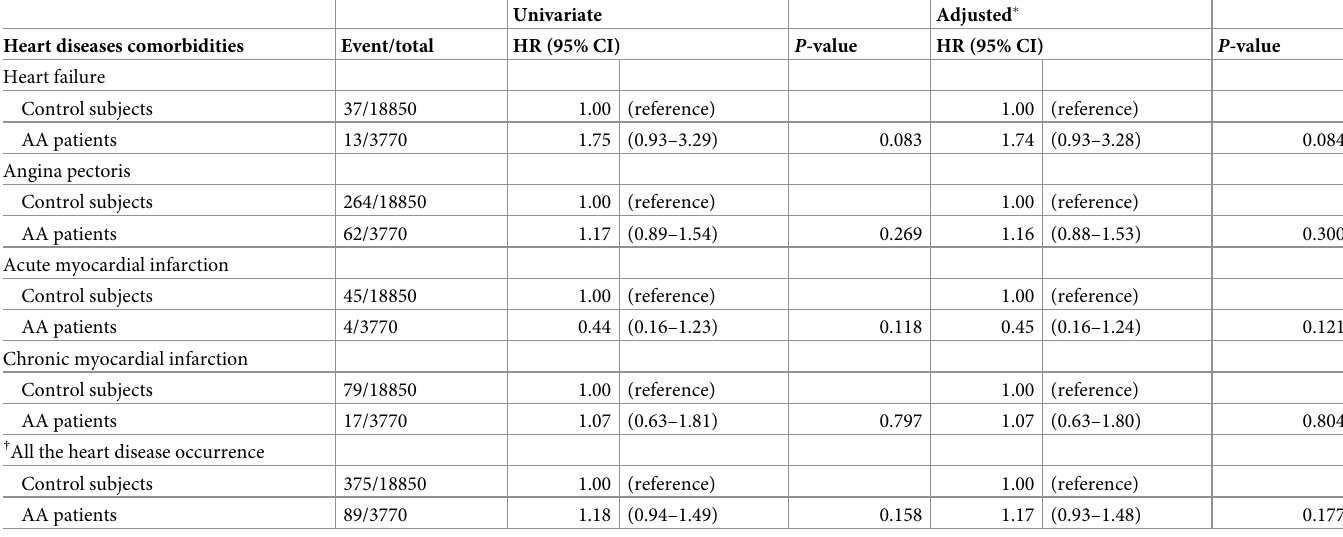
Table 2. Hazard ratio and 95% confidence intervals of heart diseases in patients with alopecia areata and in control